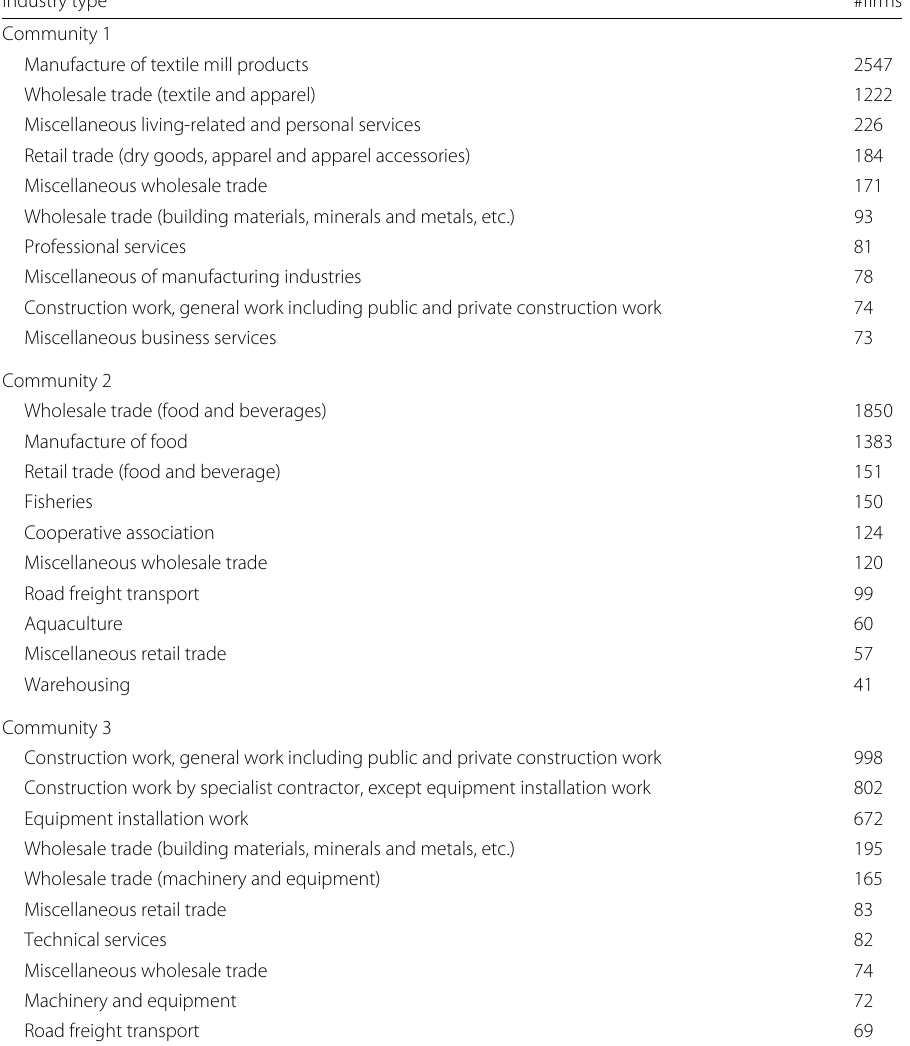
Table 4 Number of firms for each industry type that belongs to the 6 largest communities Industry